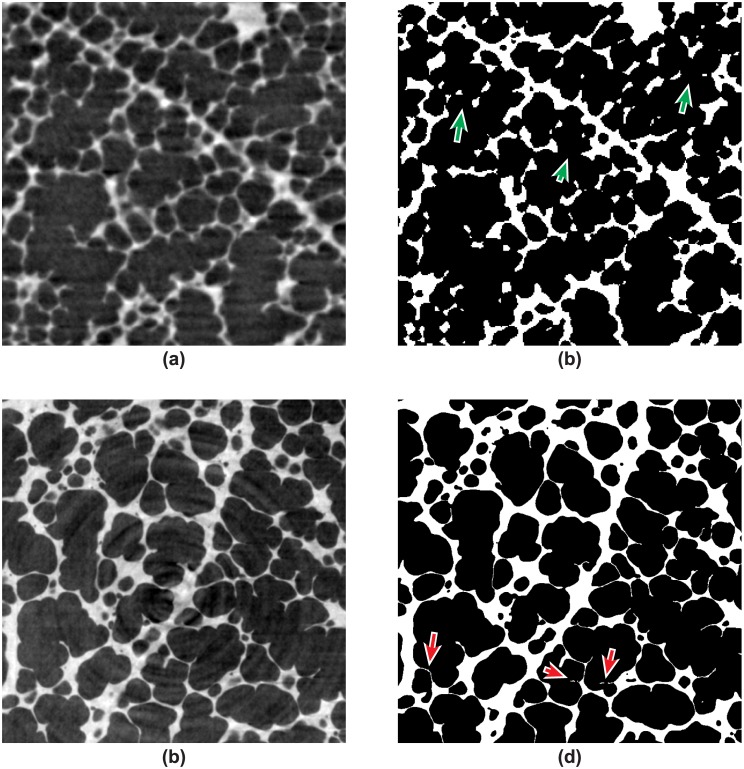
Low-resolution vs. high-resolution optics.Comparison between the low-resolution and high-resolution optics for a 0.8 × 0.8 mm2 field of view on two randomly chosen regions: (a) shows the tomographic slice of the 2.9 μm-pixel-size optics; (b) the corresponding binary segmented image; (c) shows the tomographic slice of the 1.1 μm-pixel-size optics; and (d) shows its corresponding segmented image. The arrows display artifacts introduced by the segmentation.